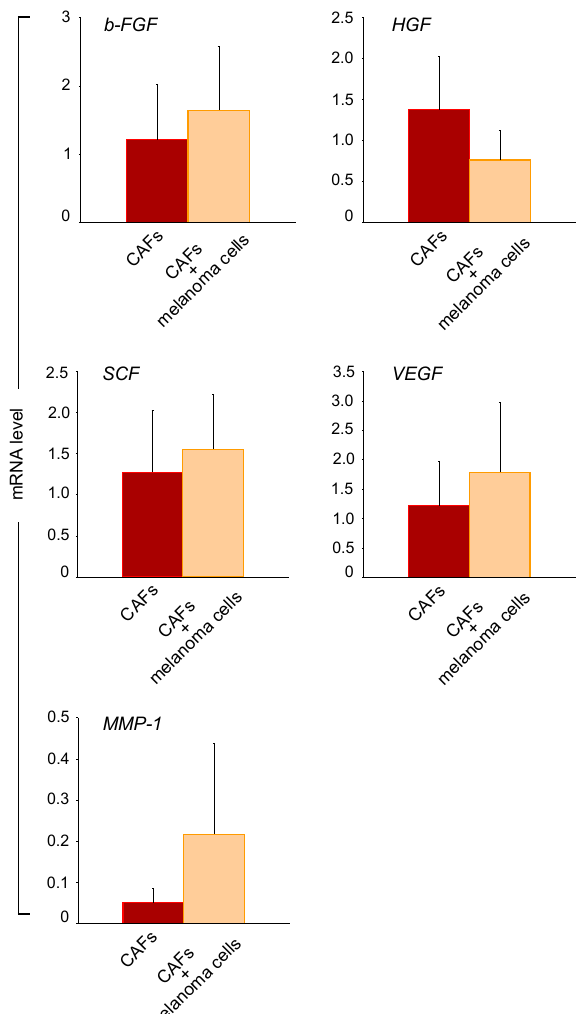
Figure 4. Gene expression evaluation in CAF/melanoma co-culture. An RT-PCR study was carried out to compare CAF gene expression in monocultured ( n = 3) and co-cultured (CAFs n = 3, melanoma cell lines n = 3) conditions. Histograms show the modification of b-FGF, HGF, SCF, VEGF, and MMP1 gene expression. β -actin mRNA was used as reference. Results are the mean ± SD of at least three independent experiments.